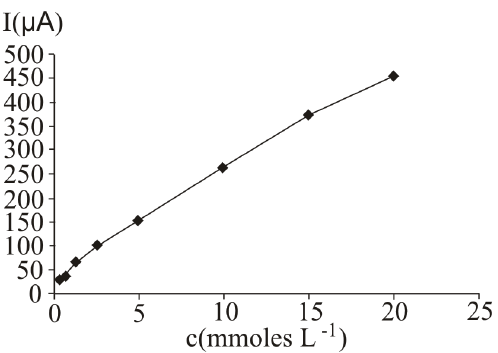
Figure 2. Calibration graph obtained at ascorbic acid determination by differential pulse voltammetry at a Pt working electrode; for experimental conditions see Figure